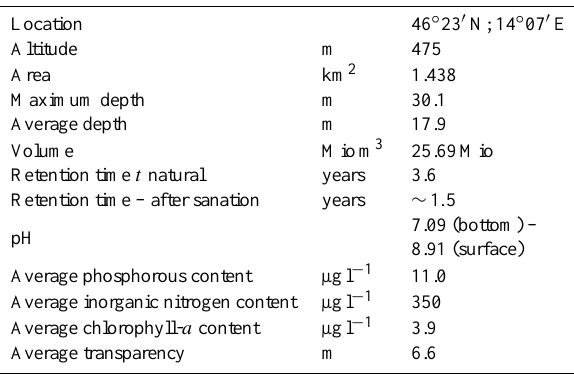
Table 1. Basic limnological features of the Lake Bled in 2008 (Remec-Rekar and Bat,